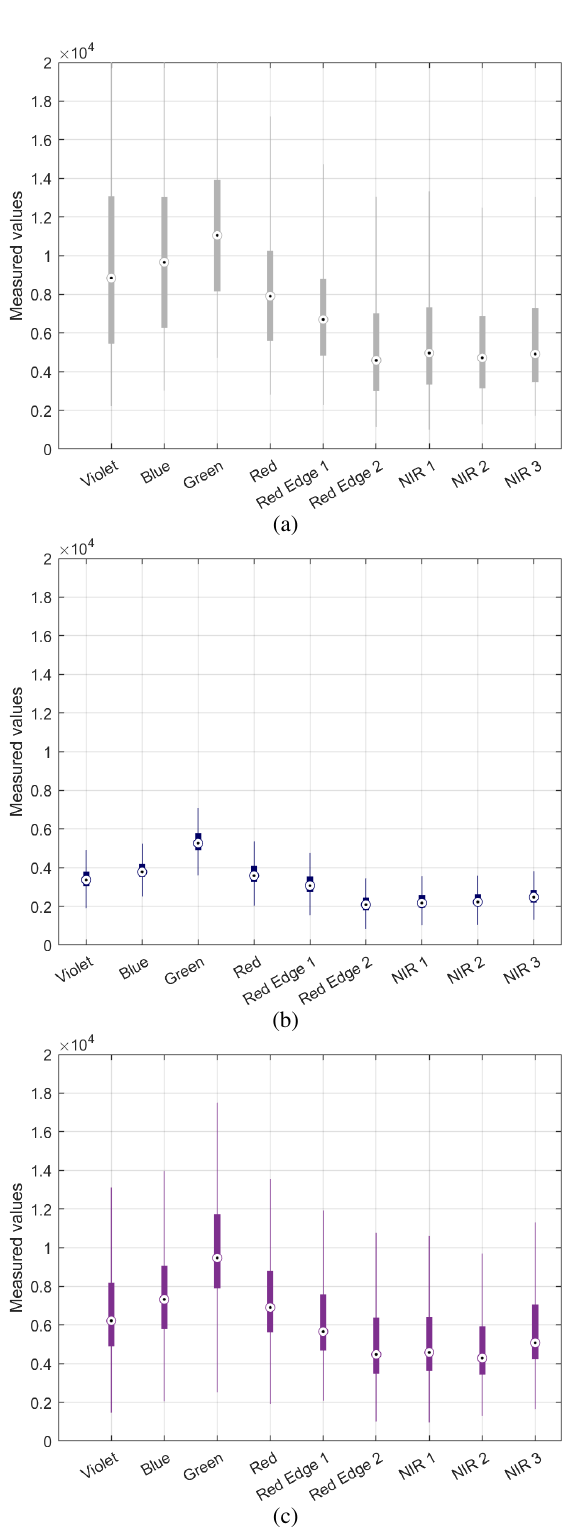
Figure 11. Examples of spectral signatures (a) transparent plastic object, (b) water, (c)